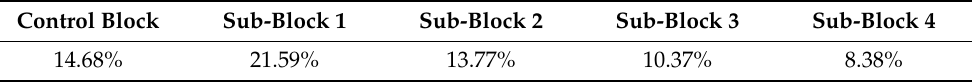
Table 3. Turbulence intensity by Equation (13) in the control block and in the four sub-blocks. Control